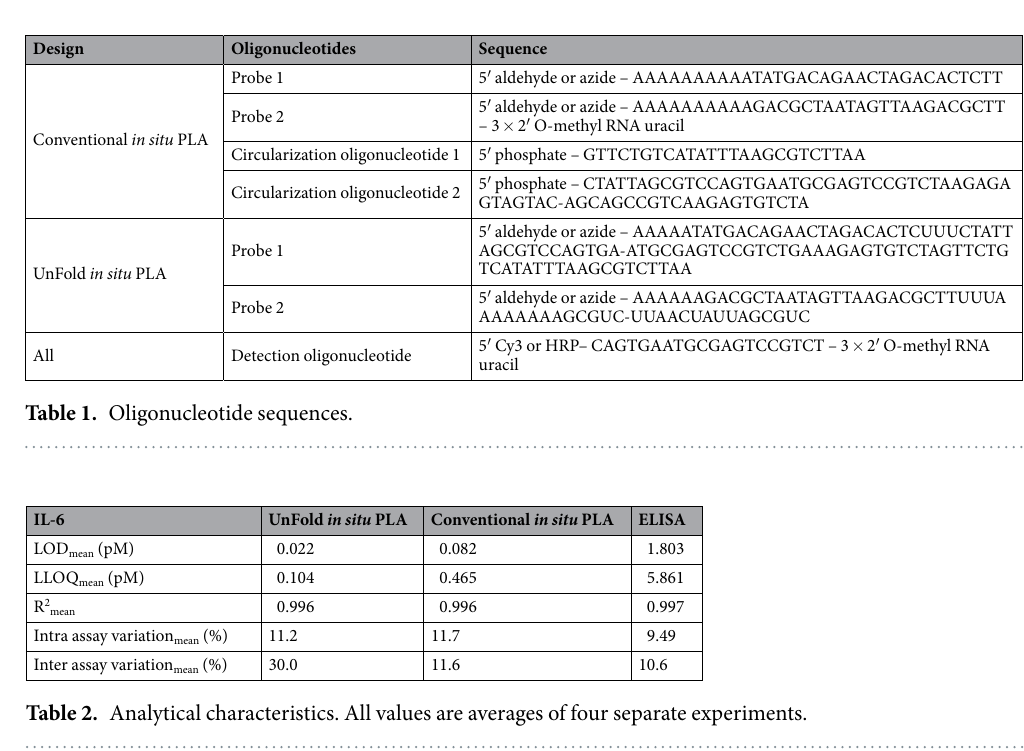
using Superdex 200 10/300 column (GE Healthcare). The collected fractions from the HPLC purification were validated by electrophoresis. Briefly, the conjugates were mixed with Novex TBE-Urea Sample buffer (Life Technologies) and separated on a Novex TBE-Urea Gel 10%, 15 wells (Life Technologies) at 180 V for 50 min. DNA was visualized using SYBR Gold Nucleic Acid Gel Stain (Life Technologies) and protein using Coomassie stain (Bio-Rad, Hercules, USA). The SYBR Gold staining was visualized with Bio-Rad Gel-Doc XR (Bio-Rad) and the Coomassie staining using an Odyssey scanner (Li-Cor Bioscience) at a wavelength of 700 nm. Concentrations of the conjugates were determined using the Dot-it Spot-it Total Protein Assay (http://dot-it-spot-it.com, Maple Stone AB) 38 according to the manufacturer’s instructions with the sample diluted in PBS containing 1% SDS and a known AB reference donkey anti-rabbit/ donkey anti-mouse dilution series for comparison. Dot-it Spot-it mem- branes were scanned using Epson Perfection V600 Photo (Epson) and analyzed using ImageJ and Excel. About 1–15% of the secondary antibody is recovered as conjugated probes.